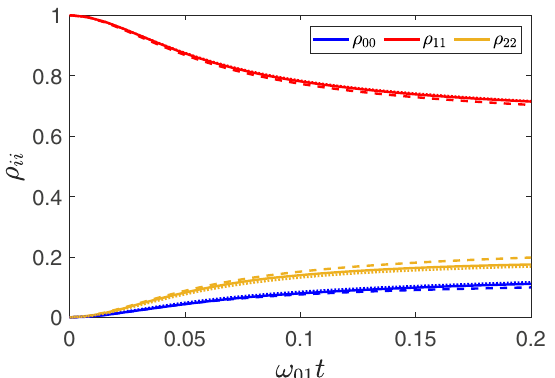
Fig. 2 Short-time dynamics of the diagonal elements of the density matrix. The diagonal elements of the density matrix for decay from the fi rst excited state calculated with SLN (solid lines), SLED (dotted lines), and our analytic solution in Eqs. (5) – (7) (dashed lines). We have used E J / E C = 100, κ / ω 01 = 0.2, β ℏ ω 01 = 5, ω c = 50 ω 01 , and N = 3.